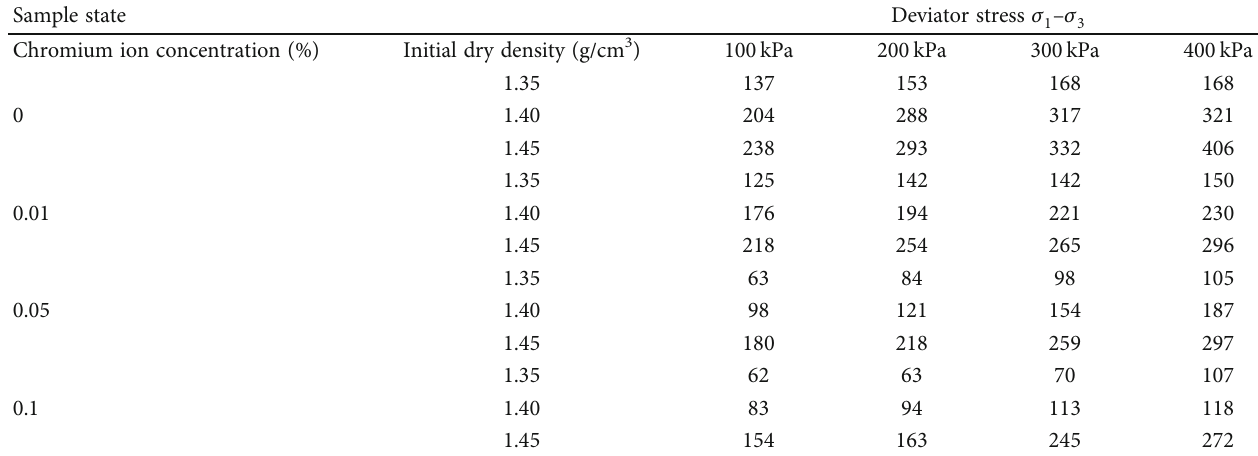
Table 3: The deviatoric stress of chromium-polluted red clay under di ff erent